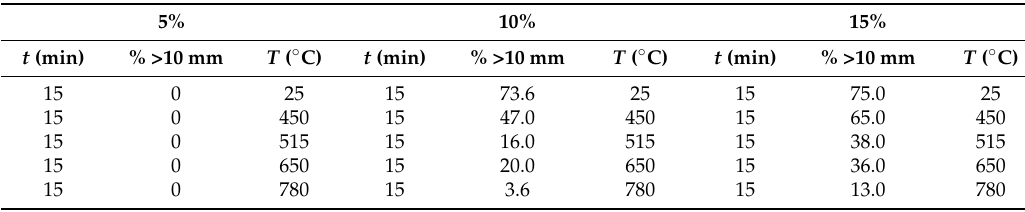
Table 1. Optimal percentage of Portland